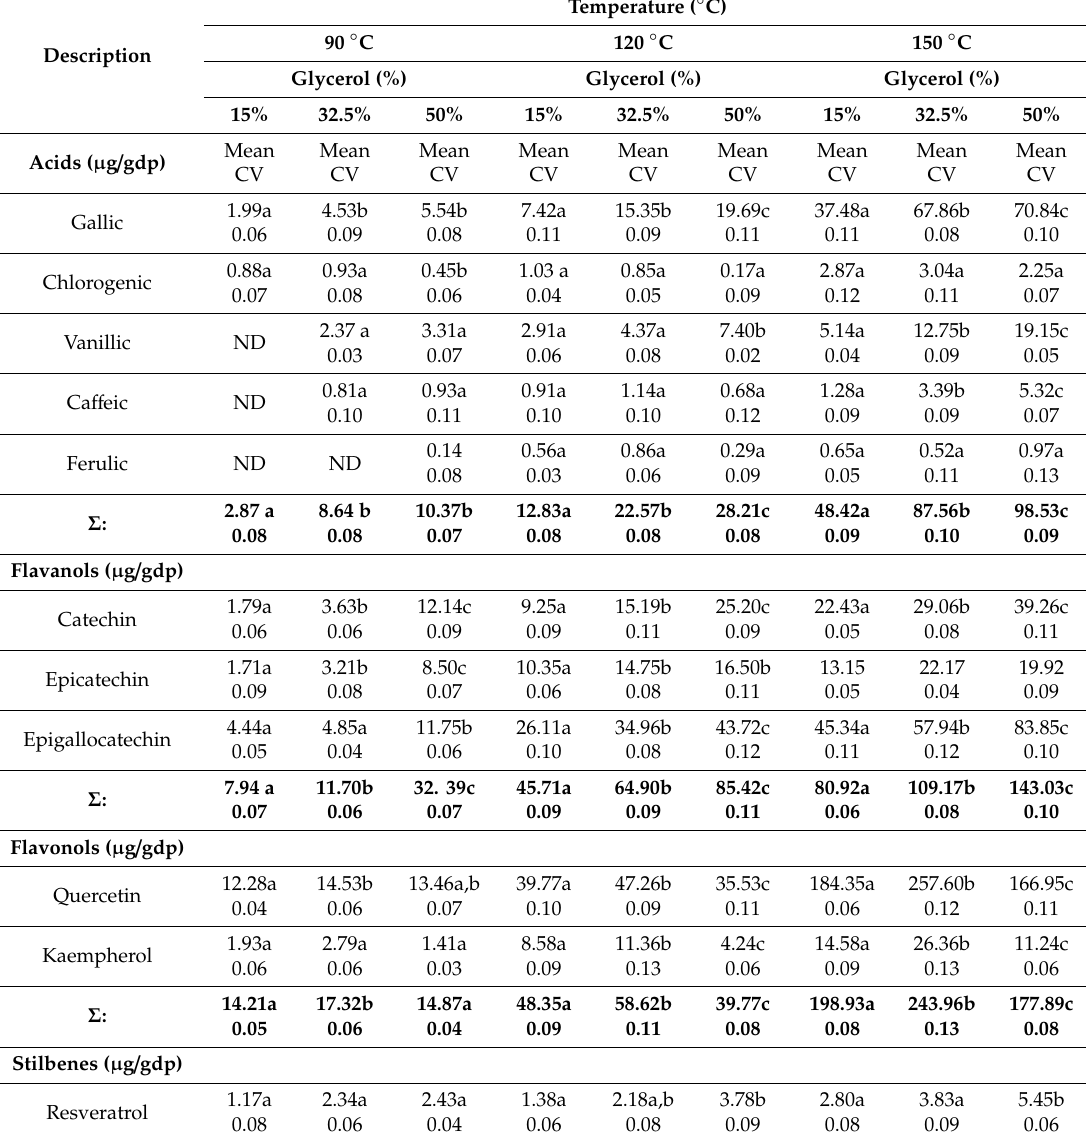
Table 1. Specific polyphenols quantified in the extracts obtained by